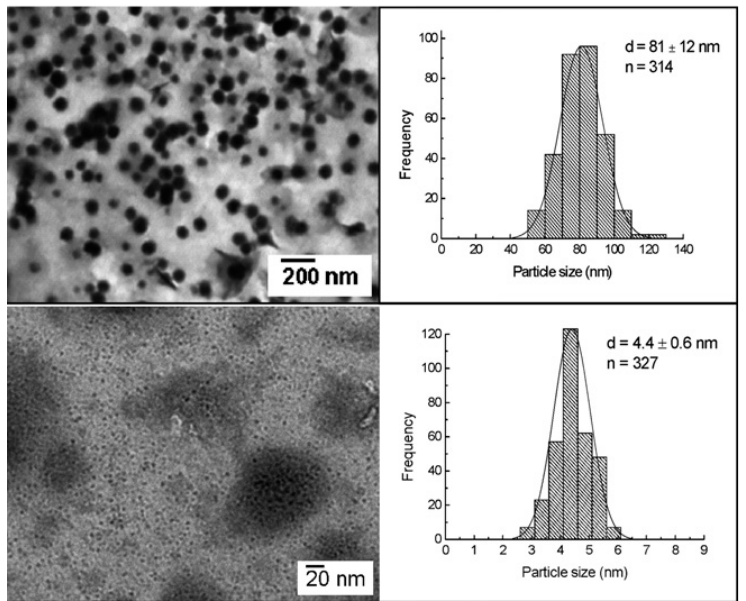
Figure 3. TEM micrographs and the corresponding size distribution histograms of the Co NPs synthesized by rapid injection ( top panels) or drop-wise addition ( bottom panels) of the reductant NaBH 4 into a mixture of CoCl 2 solution and the polymer [62].